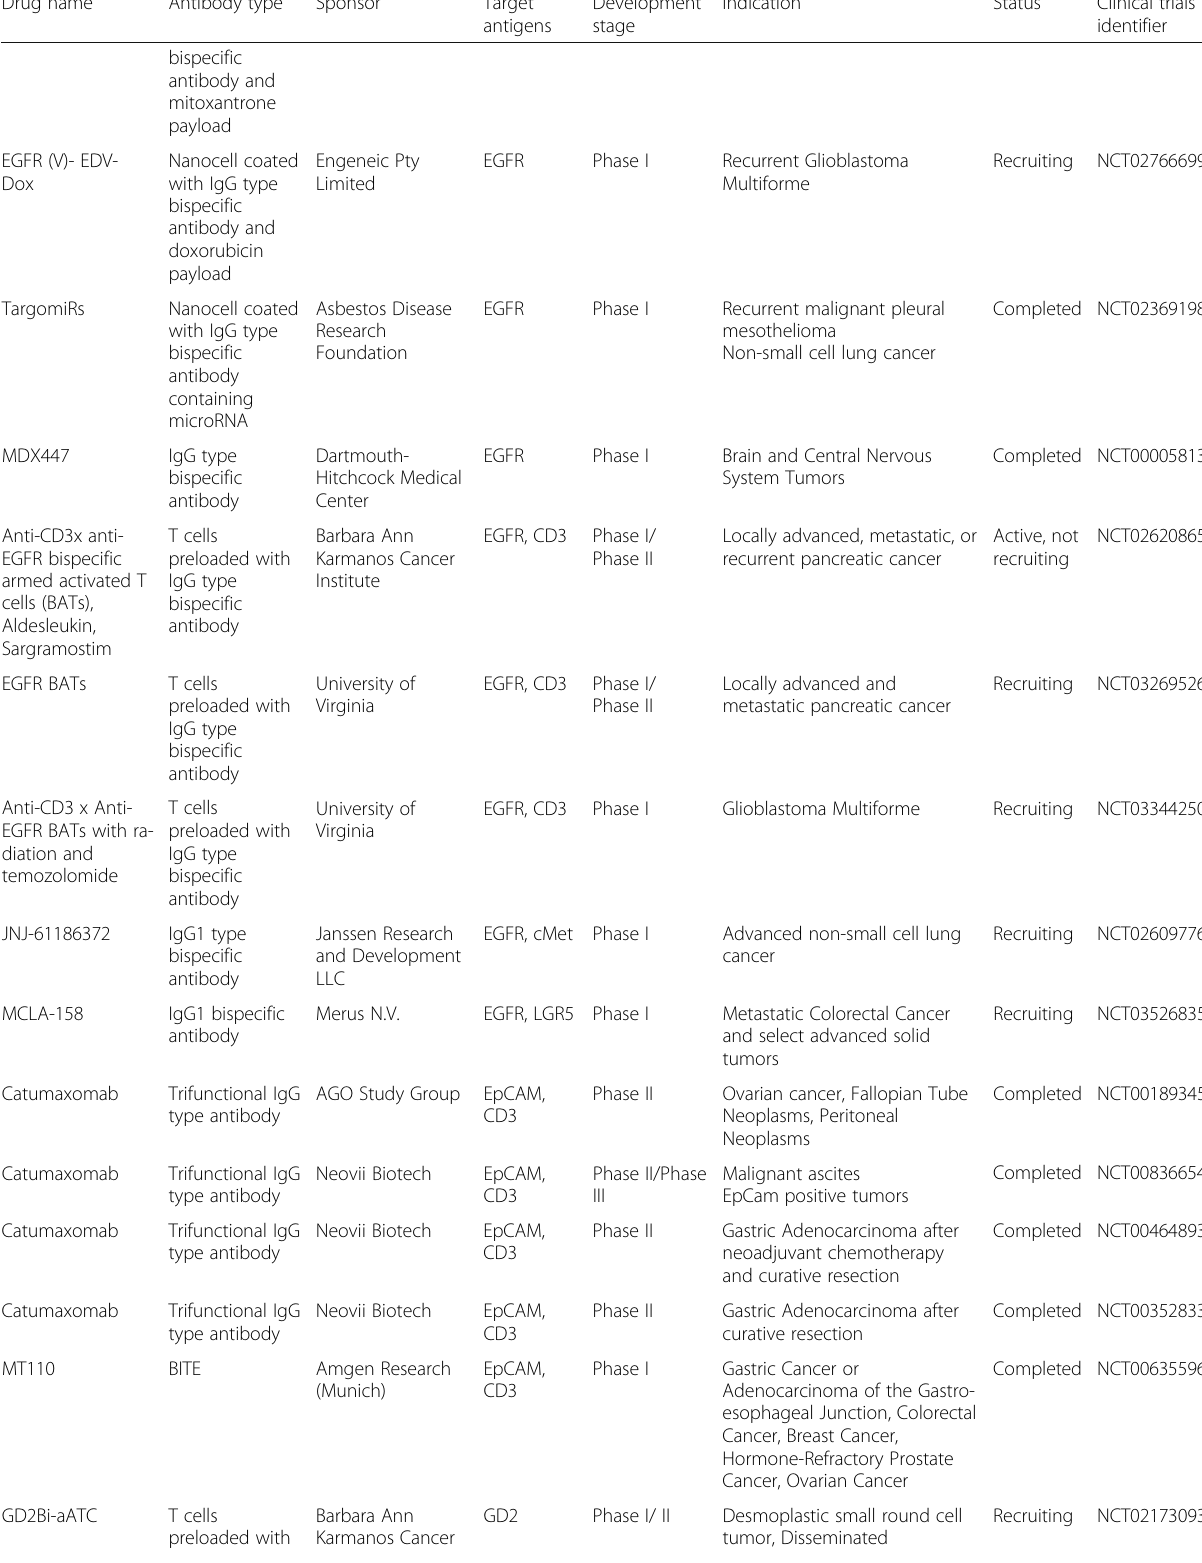
Table 4 Recent clinical trials involving the use of bispecific antibodies in solid tumor malignancies